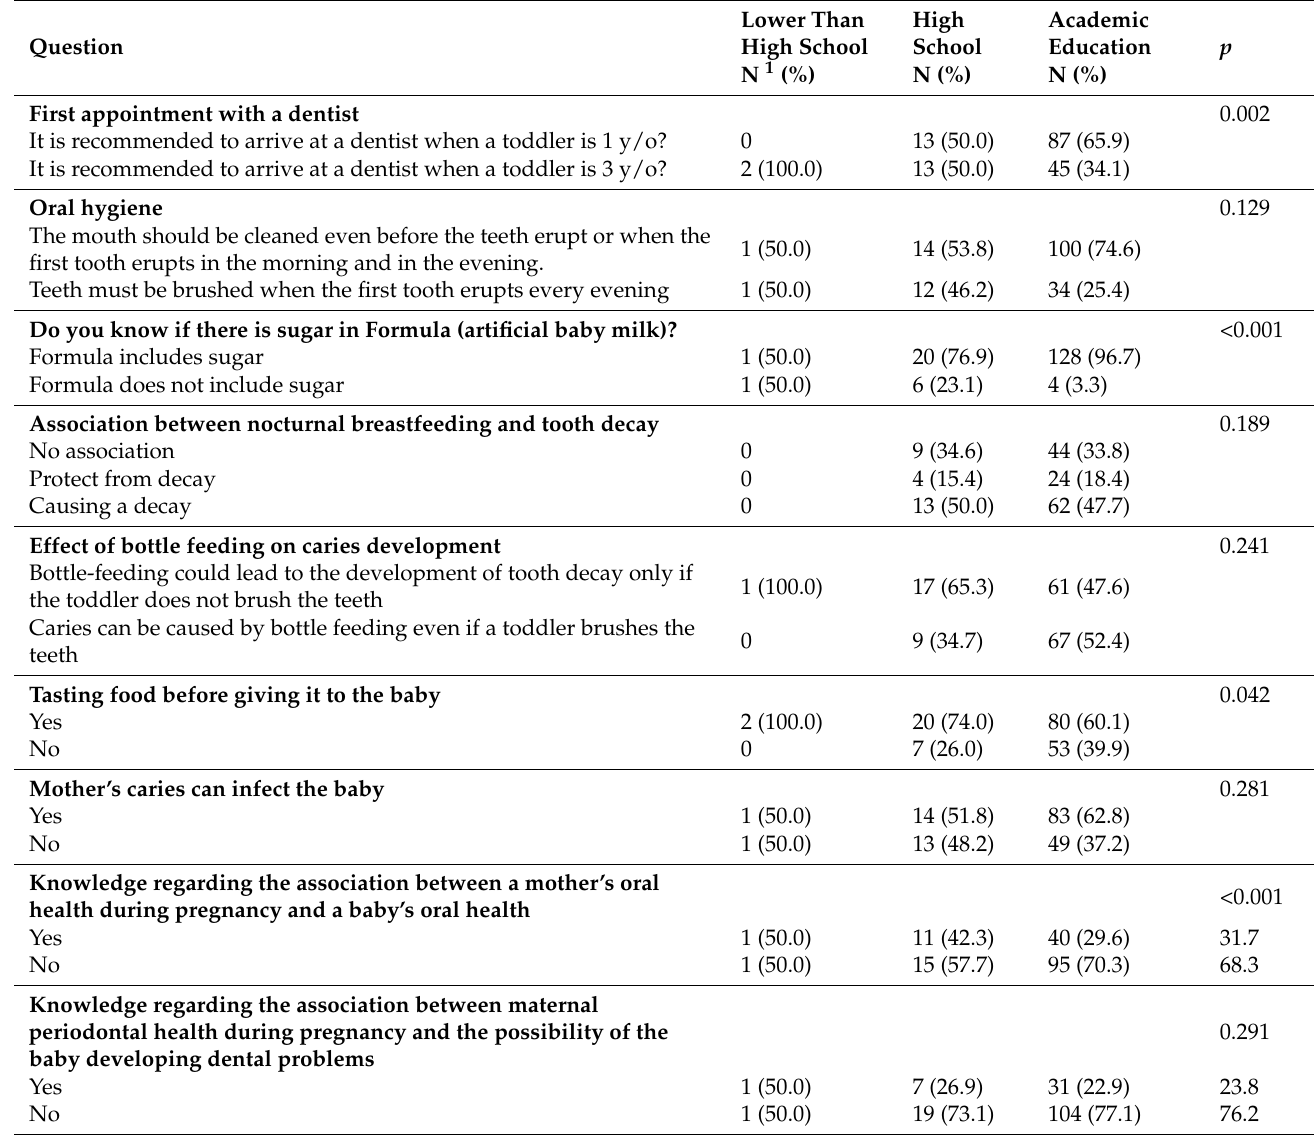
Table 4. Comparison between mothers according to education levels in knowledge about caries prevention and the health of their toddlers’